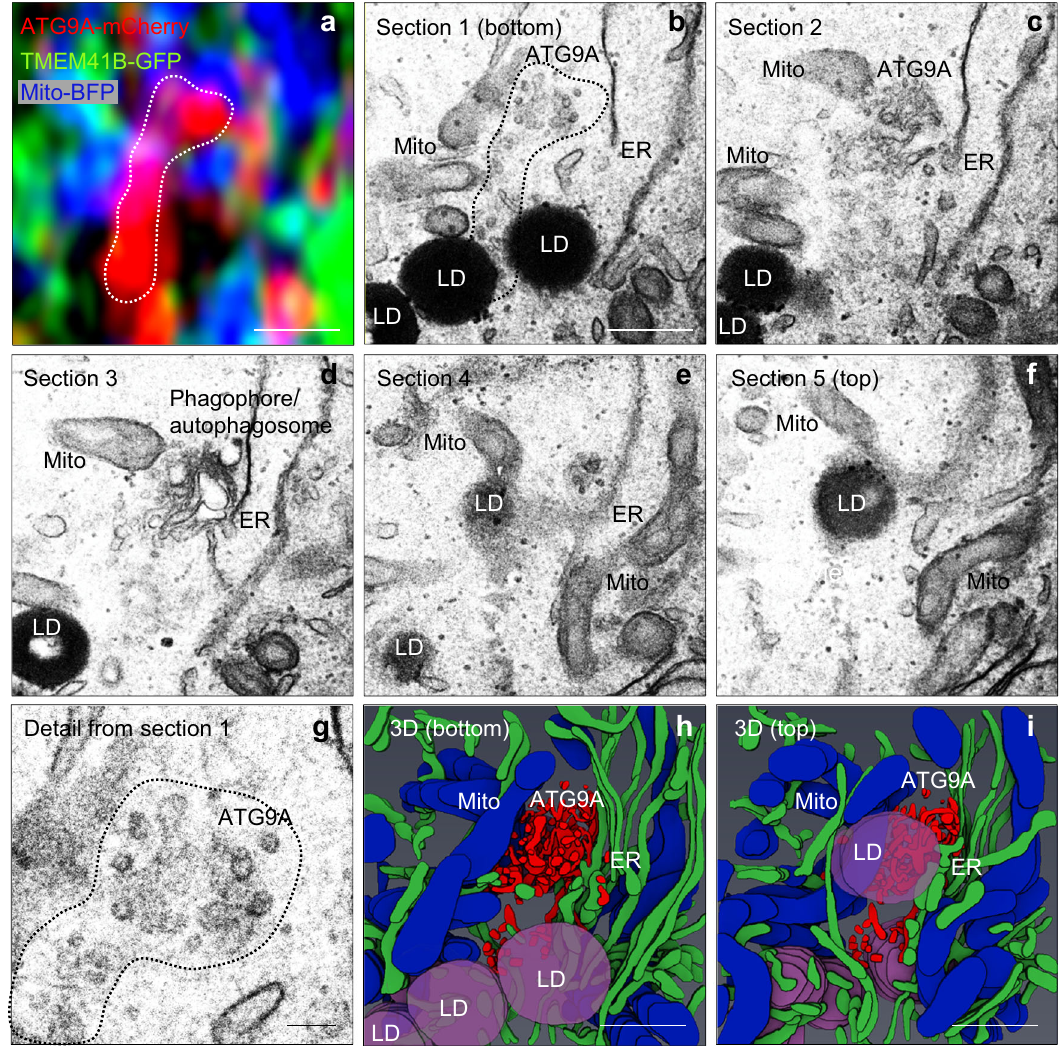
Fig. 8 Correlative light-electron microscopy of ATG9A localization relative to other organelles. HeLa cells transiently transfected with plasmids encoding ATG9A-mCherry (red), TMEM41B-GFP (green) and mito-BFP (blue) were starved for 20 min prior to fi xation and analysis by CLEM. a Airyscan image of an ATG9A-positive structure (outlined) in close proximity to TMEM41B and mitochondria. Scale bar: 0.5 μ m. b Transmission EM (TEM) image corresponding to the Airyscan image shown in panel a . Scale bar: 0.5 μ m. c – f TEM images of sequential serial sections. g Enlarged view of the ATG9A- positive structure in b showing the typical appearance of a VTC. Scale bar: 0.1 μ m. h , i 3D reconstruction of TEM images in panels b – f using Amira software, viewed from the bottom ( h ) or the top ( i ) of the cell. The identity of different organelles is indicated. Scale bar: 0.5 μ m. Results are representative from three independent